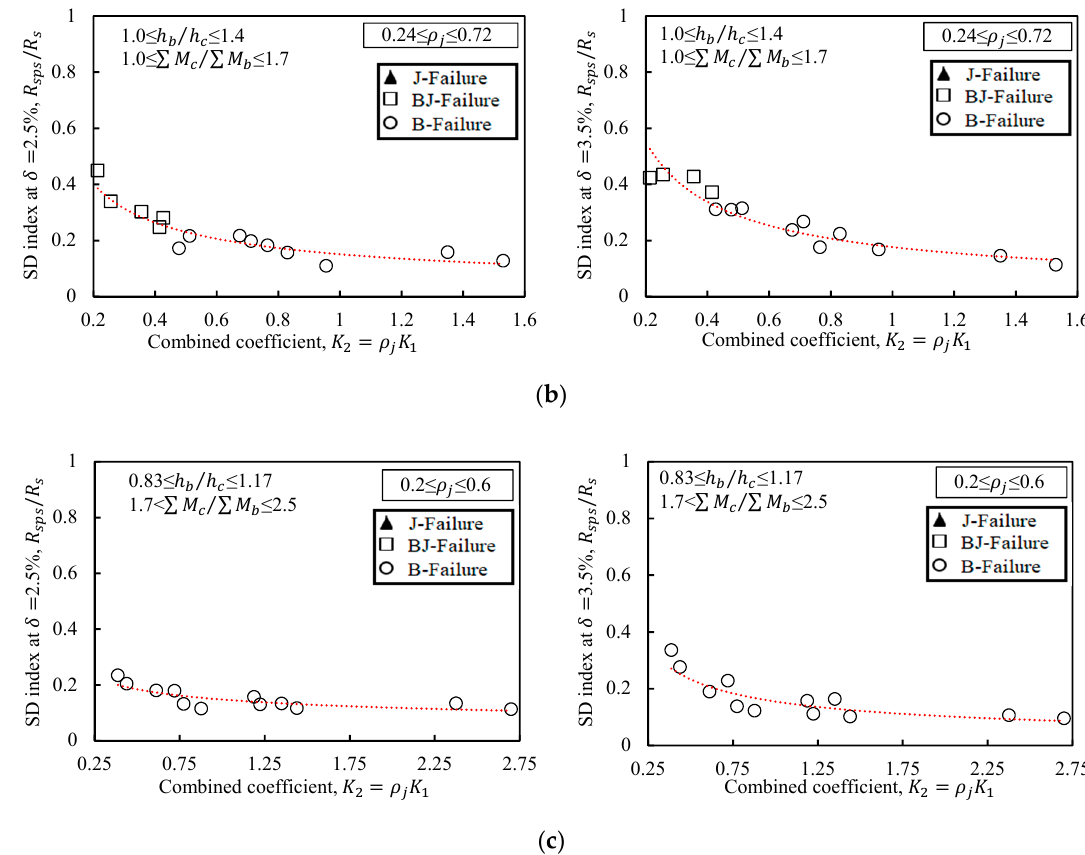
Figure 17. Shear deformation index (SDI) of interior connections for different combinations of design variables: ( a ) low ductility demand (<2); ( b ) moderate ductility demand (2–4); and ( c ) high ductility demand (>4).